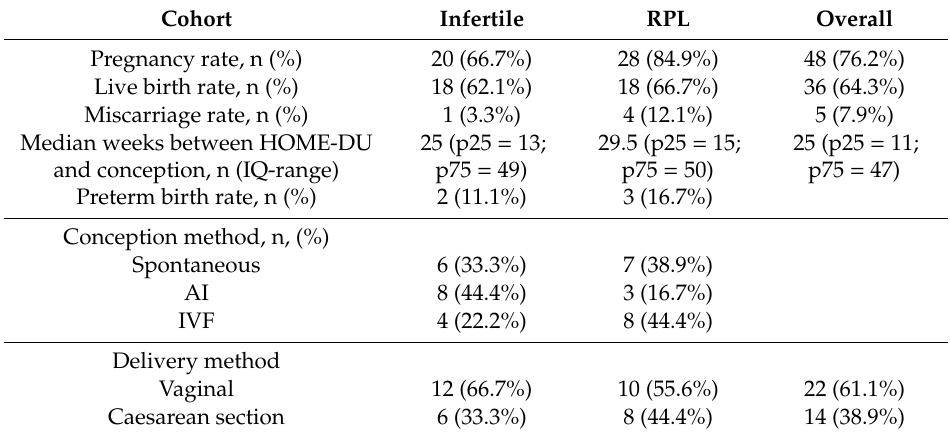
Table 2. Summary of results: reproductive outcomes in both cohorts (infertile vs. RPL